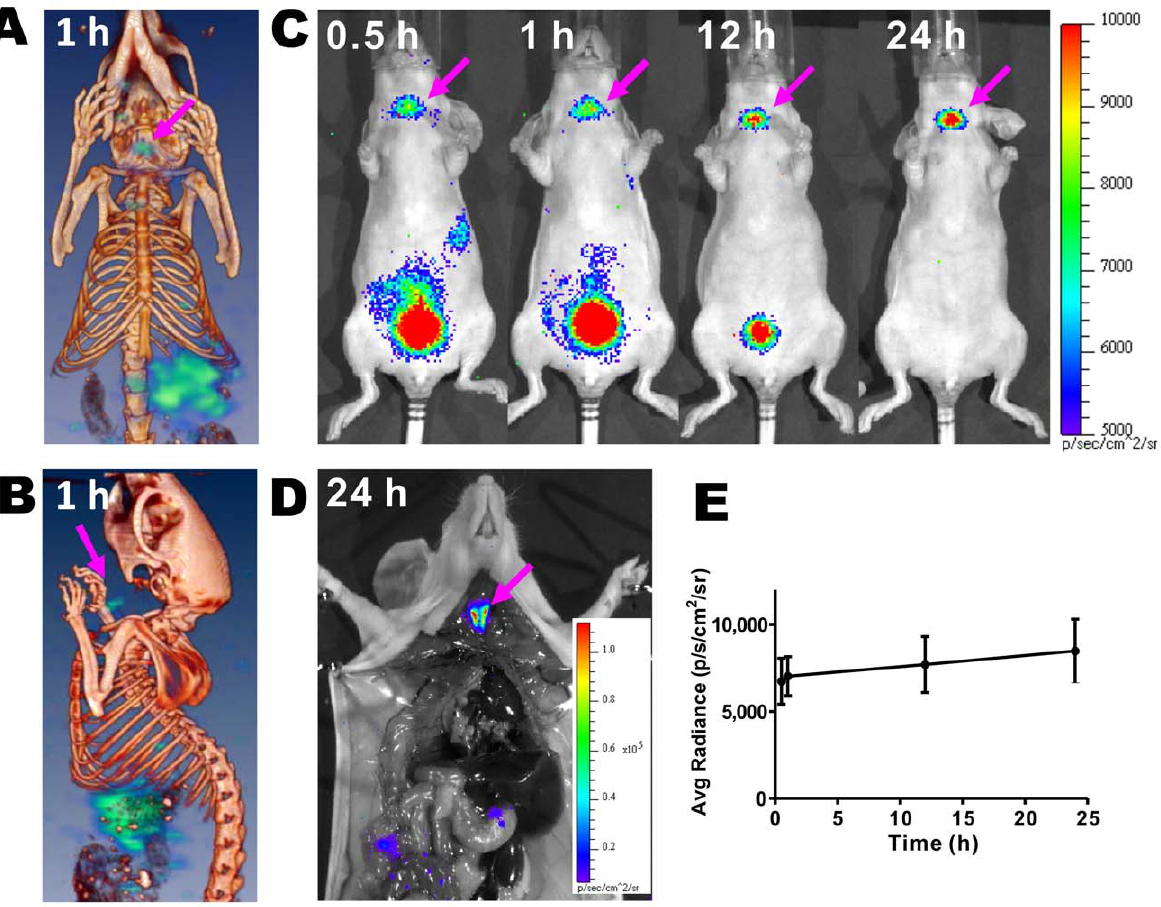
Figure 5. Invivo radioactive OI of Na 131 I compared to SPECT/CT imaging. Coronal ( A ) and sagittal ( B ) images of SPECT/CT imaging at 1 h after injection of Na 131 I probe. ( C ) Radioactive OI of a normal mouse at 0.5, 1, 12, 24 h after injection of Na 131 I via tail vein. ( D ) Radioactive OI of a normal mouse after opening the thorax 24 h post injection of Na 131 I. ( E ) Quantitative analysis (n=3) of thyroid uptake of Na 131 I from radioactive OI results.